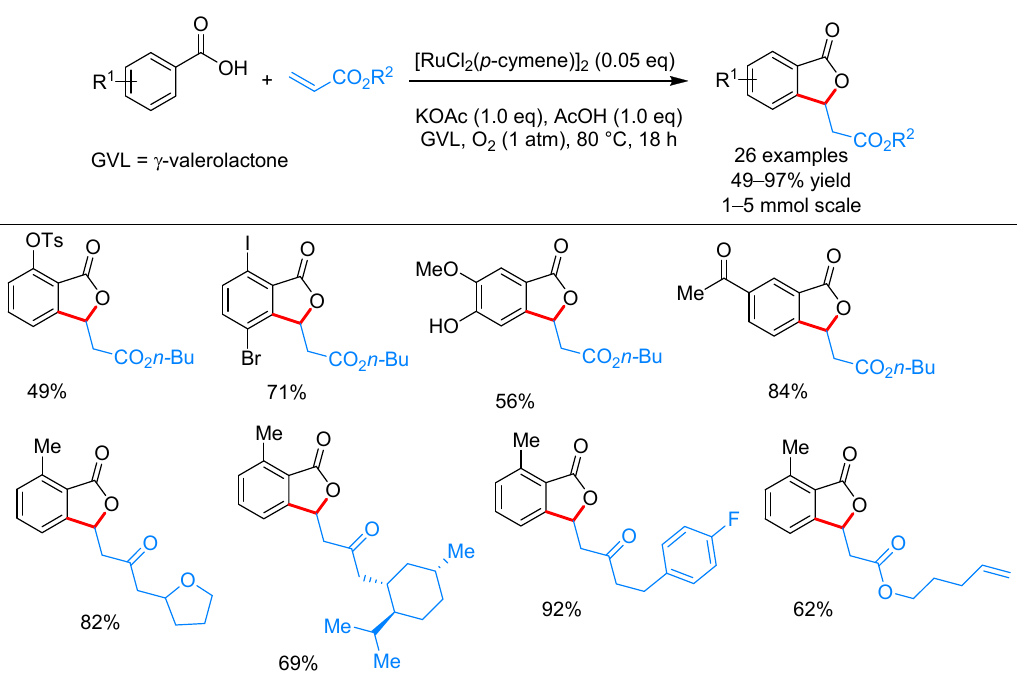
Scheme 20. Ru-catalyzed annulative coupling of benzoic acids and electrophilic alkenes for the synthesis of 3-substituted phthalides in GVL in the presence of O 2 synthesis of 3-substituted phthalides in GVL in the presence of O 2 . synthesis of 3-substituted phthalides in GVL in the presence of O 2 .